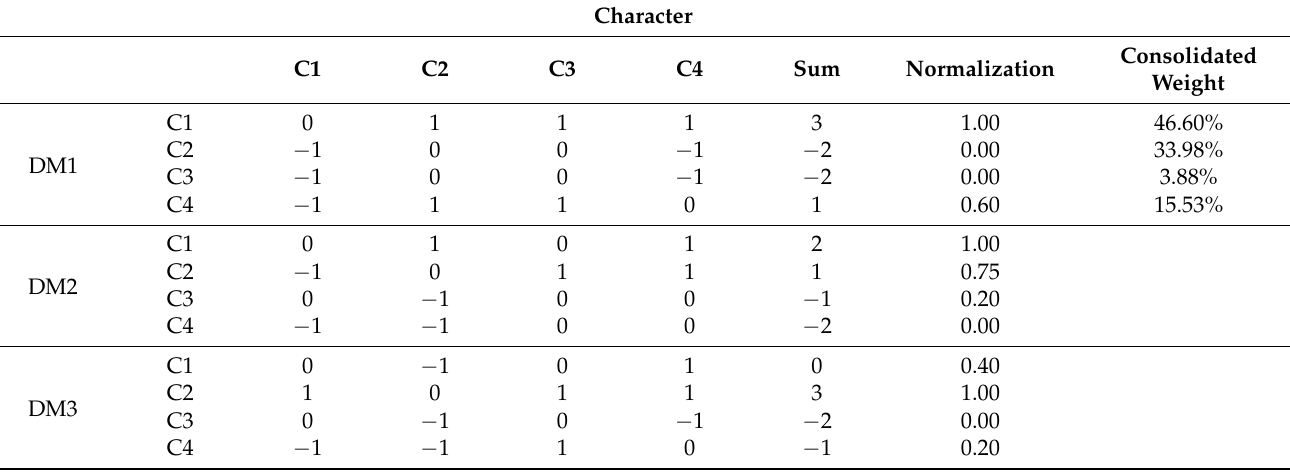
Table 8. Paired comparison between the subcriteria of the criterion